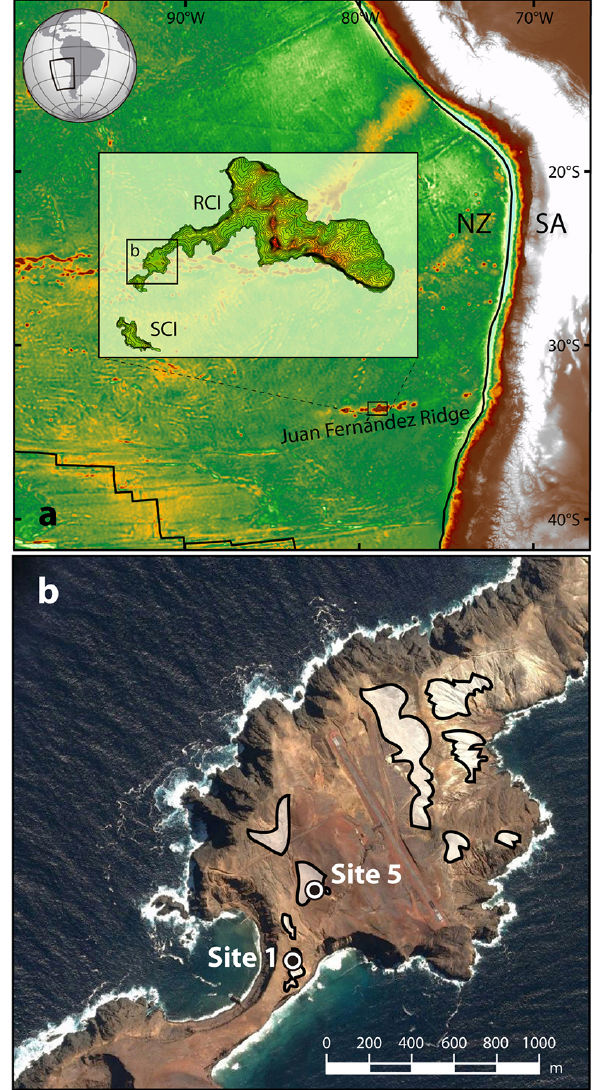
Figure 1. (a) Location of Juan Fernández Ridge, with Robinson Crusoe Island (RCI) and Santa Clara Island (SCI) in a box. (b) A satellite image of the southwestern “panhandle” where the aero- drome is situated. White areas are those of the Bahía Tierra Blanca succession, where a well-exposed supratidal Holocene sequence was dramatically uplifted (see text for details). Sampling sites la- belled with numbers (see Table 1). NZ: Nazca Plate; SA: South American